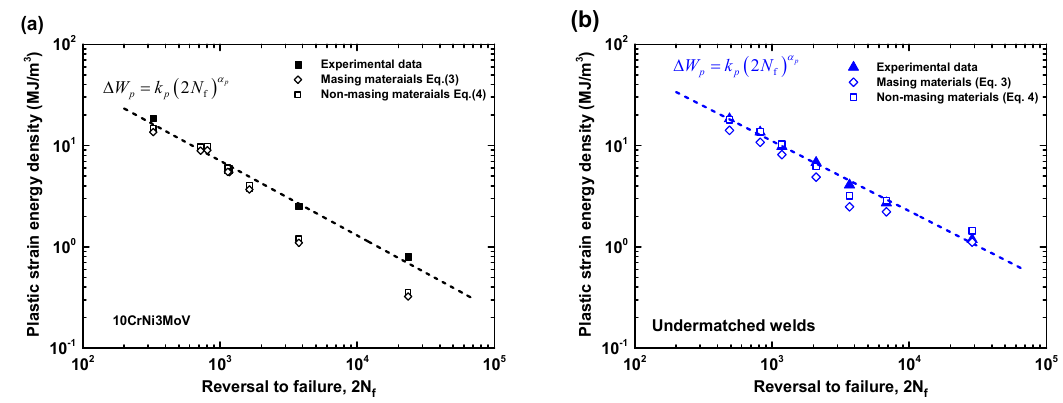
Figure 11. Comparison of Plastic strain energy density ∆ W p between 10CrNi3MoV high strength steel and undermatched welds.